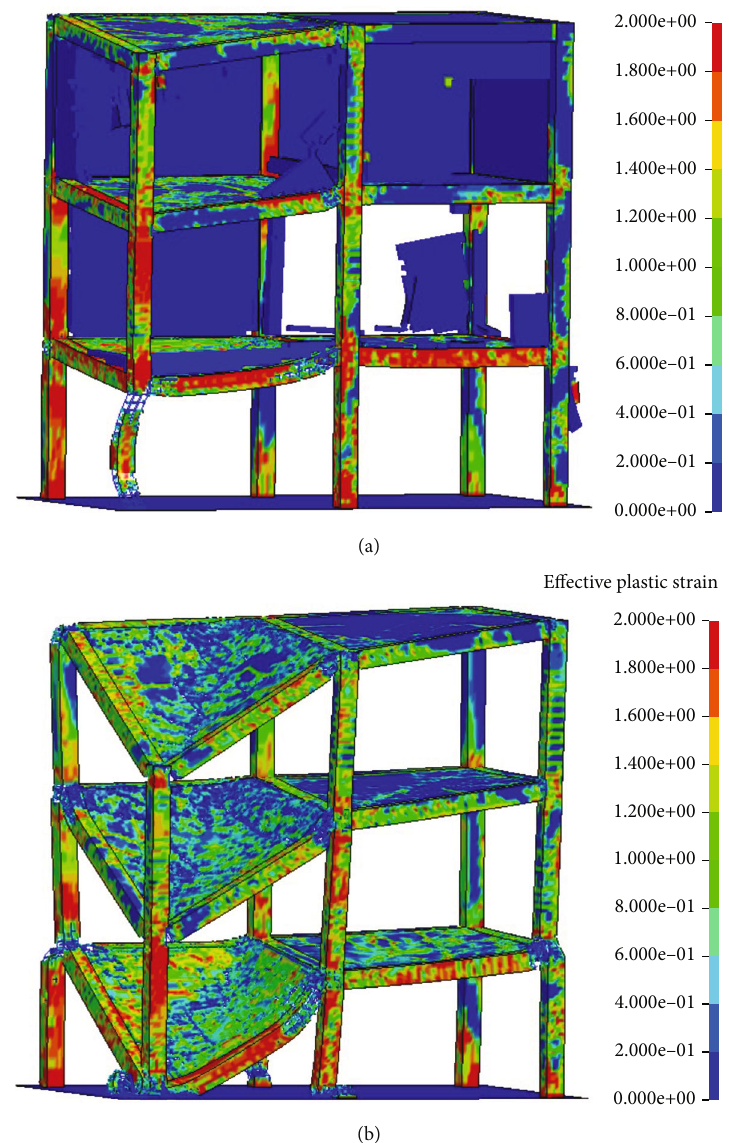
Figure 10: Collapse state of the frame when the side column at ground fl oor is damaged. (a) Frame 1. (b) Frame